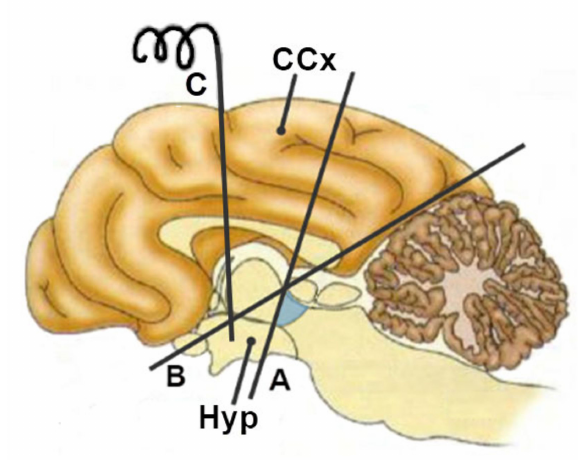
Figure 2. Schematic representation of Bard’s experiments on cats. Behavior described as “false anger/false rage” occurs if the cutting line when decorticating a cat goes from the posterior part of the cerebral cortex through the anterior part of the hypothalamus (line marked with ( B )), but not if it goes through its posterior part (line marked with ( A )). In both cases, a small part of the caudoventral part of the thalamus remains preserved (marked in blue). Electrical stimulation of the hypothalamus with an electrode (without cutting) leads to anger and fear ( C ). The schematic follows Bard’s textual description (Bard, 1928) [35]. CCx—cerebral cortex; Hyp—hypothalamus. See text for